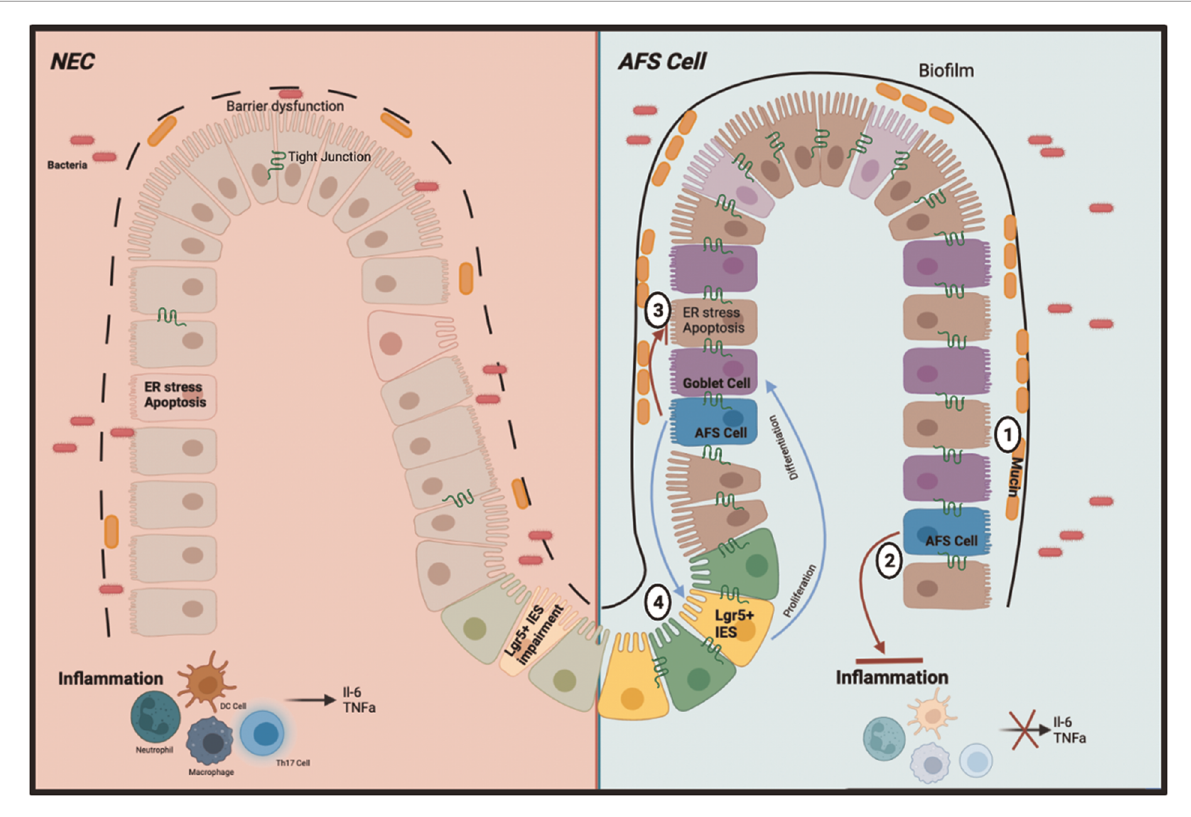
FIGURE 2 Schematic of the mechanism of action of AFSC in preclinical study. ( 1 ) Increased production of mucin levels by goblet cells due to increased differentiation ( 2 ) Inhibited in fl ammatory pathways and subsequent cytokines ( 3 ) Inhibited ER stress response and subsequent apoptosis ( 4 ) Restored function of ISCs to induce cell proliferation and